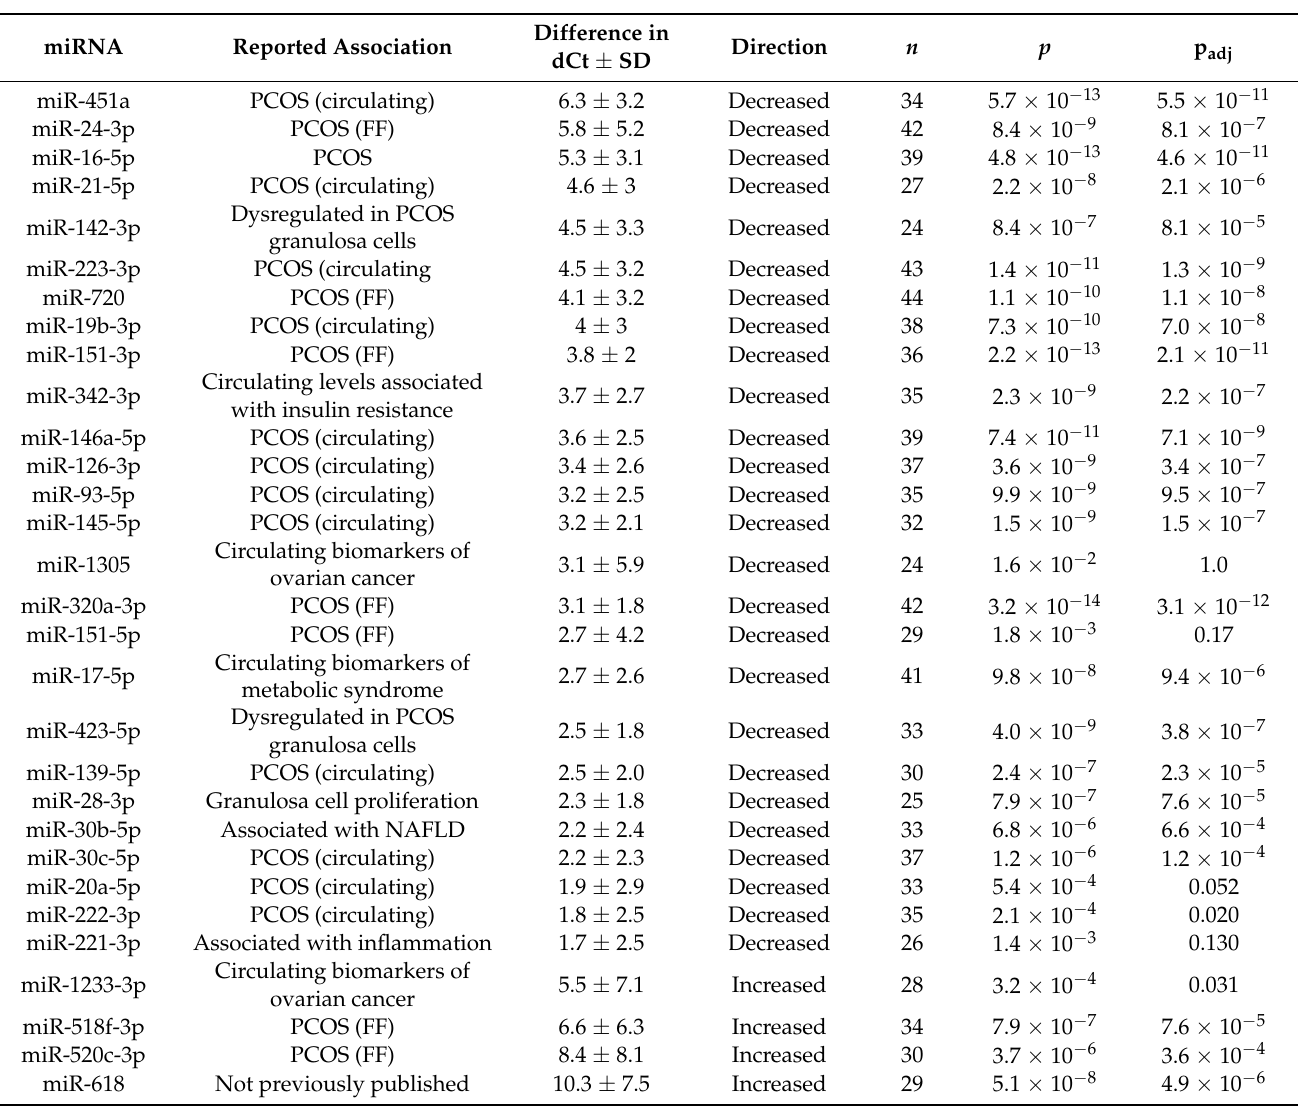
Table 2. Thirty miRNAs change over time in PCOS women. Shown are the mean fold change ± standard deviation as well as the number of women included. Changes in expression levels were evaluated with a paired student t -test. p values were corrected for multiple testing using Bonferroni corrections. MiRNAs are human miRNAs ( hsa-miR ) unless otherwise specified. Some assays were designed for murine miRNAs, but in these cases, the miRNA was completely homologous. PCOS (FF): Levels in follicular fluid associated with PCOS, PCOS (circulating): Levels in circulation associated with PCOS. NAFLD: Non-alcoholic fatty liver